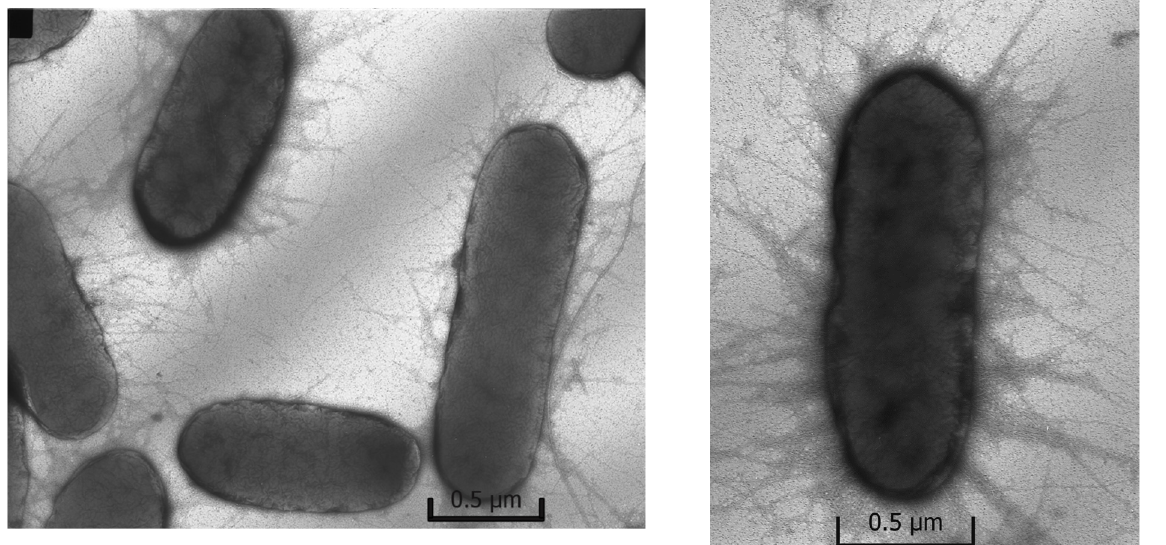
Figure 7. Photomicrograph of Escherichia coli , control.